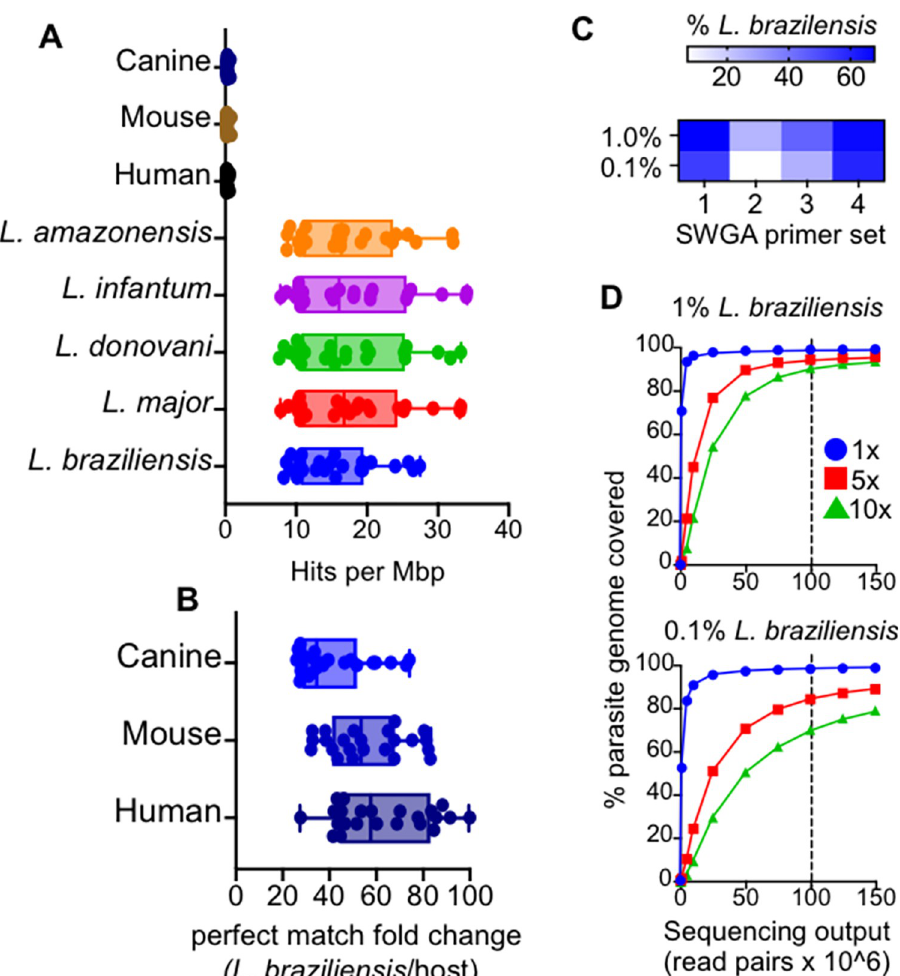
Fig 1. SWGA primer design and evaluation. (A) The number of exact match ‘hits’ per megabase (Mbp) for each of the 23 identified SWGA primers against Leishmania and host reference genomes, and (B) the fold difference in exact matches against L . braziliensis compared to human, mouse, or canine genomes. (C) Heatmap showing percent reads aligning to L . braziliensis for each of the four SWGA primer sets used to carry out SWGA on known ratios of L . braziliensis DNA spiked into human genomic DNA (0.1 and 1% final parasite DNA). (D) The number of reads is shown in relation to the percentage of the parasite genome covered at � 1x (blue line), 5x (red line) and 10x (green line). Vertical dashed line indicates a sequencing effort of 100 x 10 6 150bp paired-end